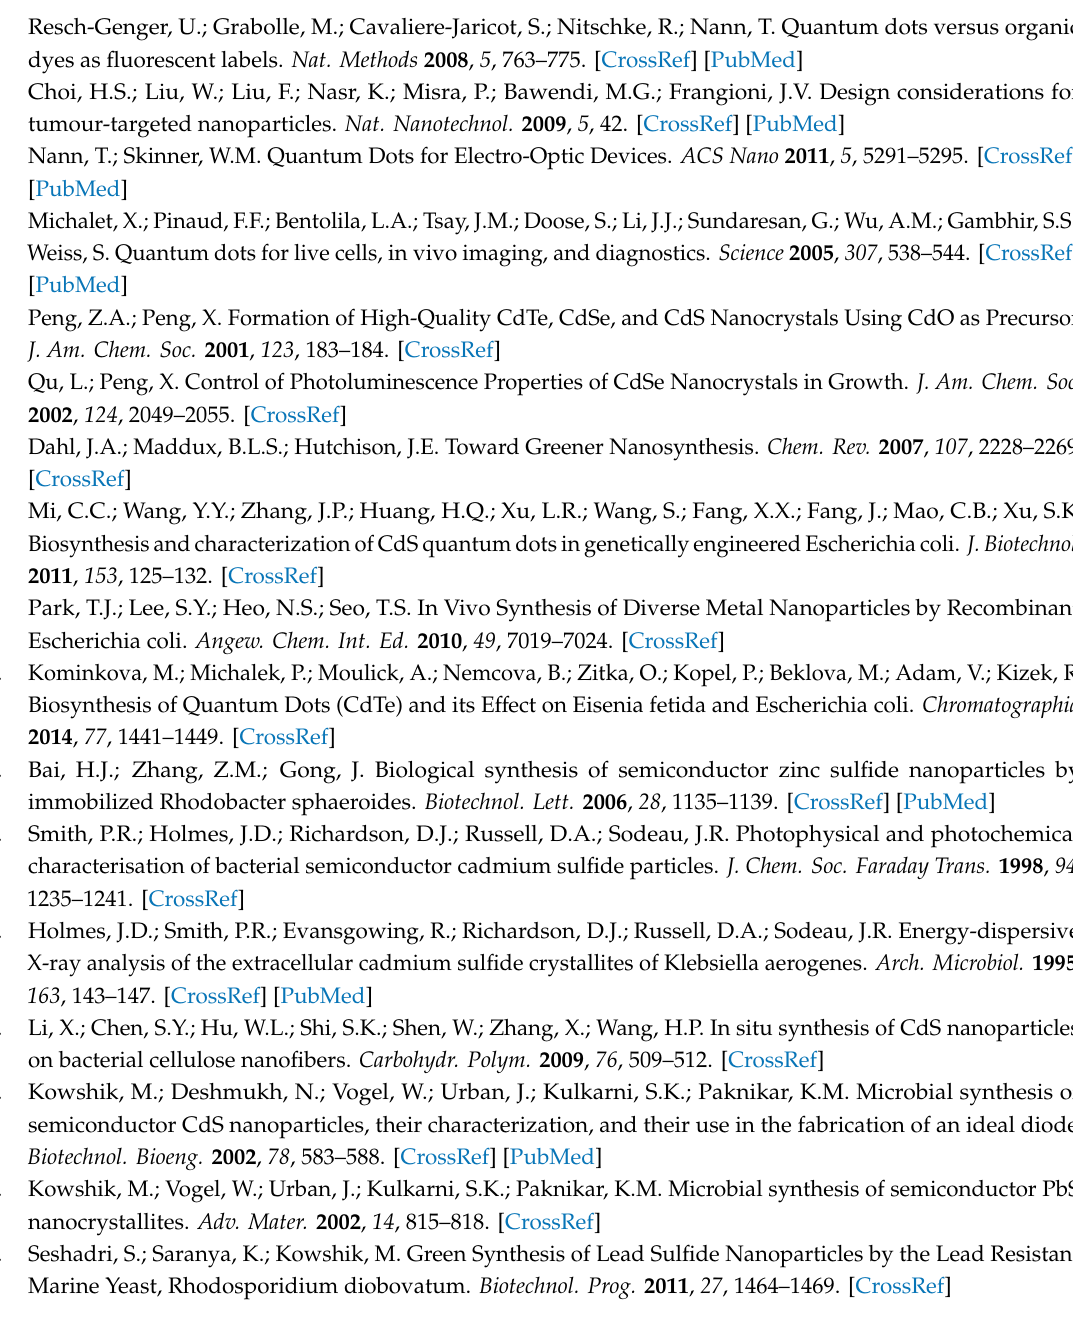
Figure S1: EDX, Figure S2: Growth curve VRSA, Figure S3: Growth Curve MRSA, Figure S4: Growth Curve E. Coli, Figure S5: VRSA viability count, Figure S6: MRSA viability count, Figure S7: E. coli viability count, Figure S8: CFU VRSA, Figure S9: CFU E.